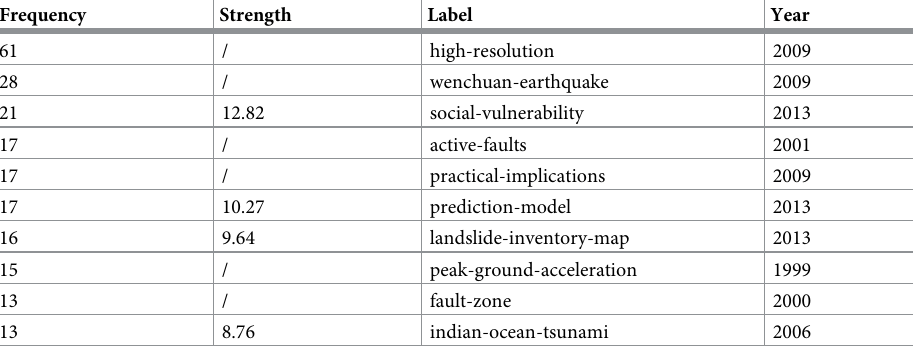
Table 4. The list of three classifications used for retrieving natural disaster literature.